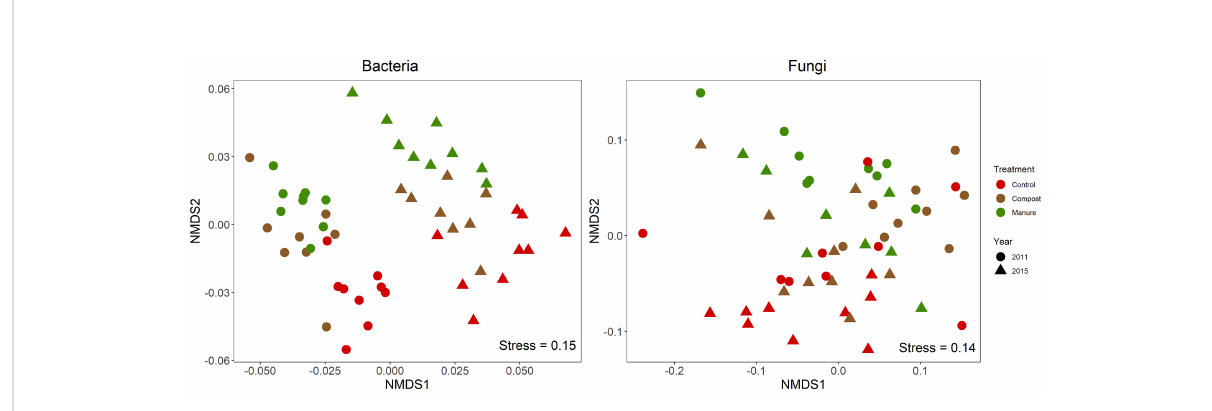
FIGURE 1 Nonmetric multidimensional scaling (NMDS) ordination of the weighted UniFrac distance for soil bacterial and fungal communities. PERMANOVA indicates signi fi cant effect of organic N treatment and Year on both bacterial and fungal community compositions (p <